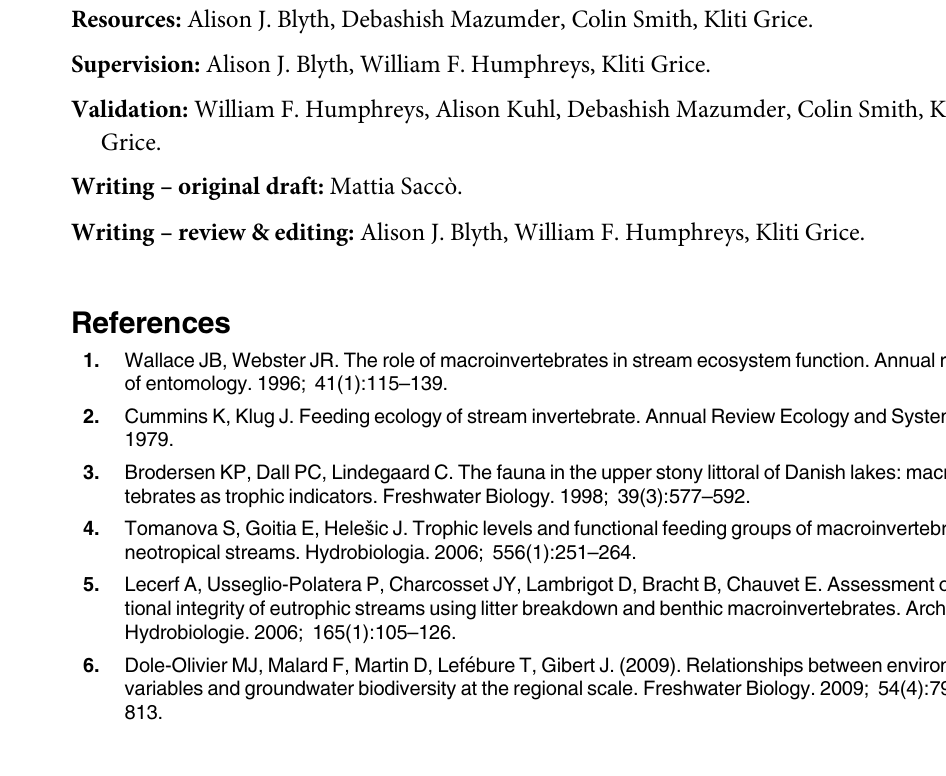
S4 Table. Dietary proportions of P. macrosturtensis (B), P. mesosturtensis (M) and P. microsturtensis (S) under LR and HR